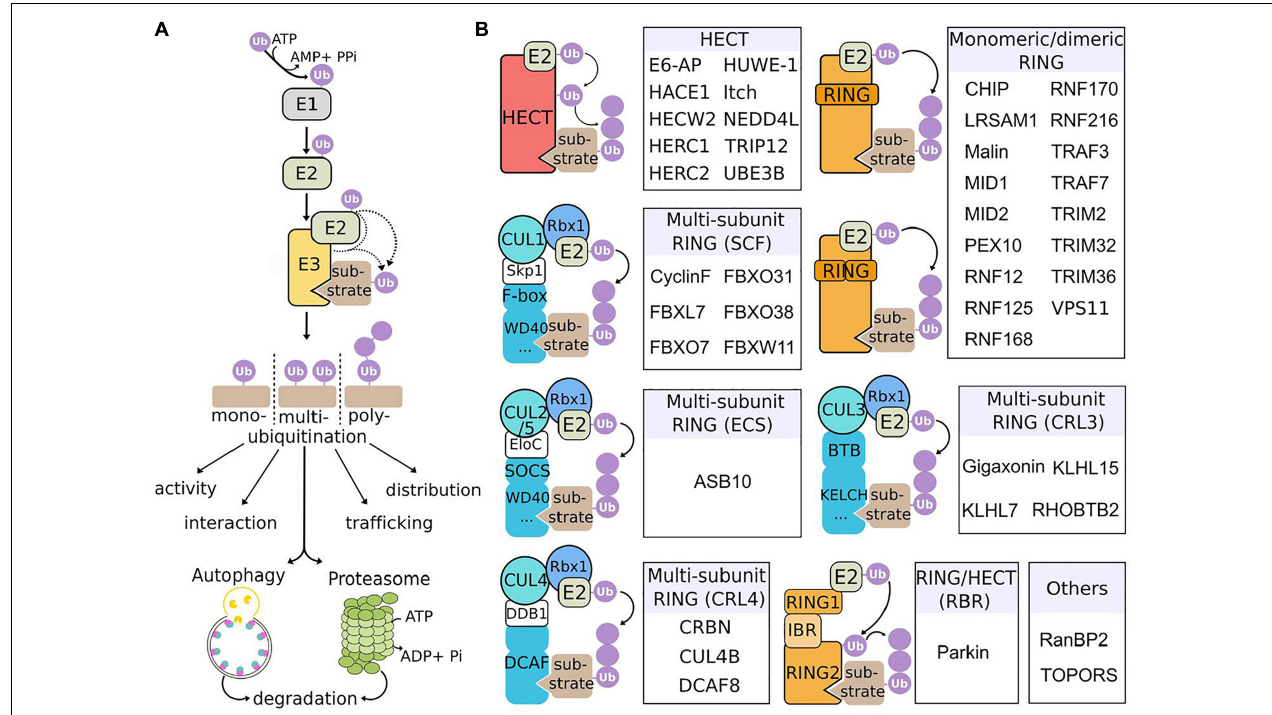
FIGURE 1 | Mechanism of action and classification of E3 ubiquitin ligases causing neurological diseases in human. (A) Ubiquitination cascade. E1 enzymes activate ubiquitin (Ub) in an ATP-dependent manner, forming a thioester bound with Ub. Activated-Ub is then transferred to Ub-conjugating enzymes (E2). Finally, E3 ubiquitin ligases assist or directly catalyze the transfer of Ub to substrates. Substrates can be mono-, multi- or poly-ubiquitinated, with different types of Ub chains, to modulate various processes, including protein activation, interaction, trafficking, subcellular localization, and degradation through the 26S proteasome or the autophagy pathway. (B) E3 ligases underlying neurological diseases and their classification. The three classes of E3 (HECT, RING, and RING-HECT hybrid) are represented. E3 ligases identified as the genetic cause of neurodevelopmental and neurodegenerative diseases in human are classified within each category (sub-classes with no disease representative are not shown). The HECT and RING E3 ligases differ in the way they transfer Ub to the substrate. The HECT E3s receive Ub from E2 enzymes, form a thioester intermediate with Ub, and catalyze the transfer to the substrate. RING E3s associate with E2 enzymes and substrates and mediate the transfer of Ub from E2 to the substrate. RING E3s can function as monomers, dimers or multi-subunit RING E3s. The latter class is subdivided in different groups, among which the Cullin-RING Ligases (CRLs) are the largest E3 ligase family. SCF, ECS, CRL3 and CRL4 ligases are composed of a modular E3 core containing specific Cullins (respectively CUL1, CUL2/5, CUL3, CUL4) and RBX1 (RING-box1 proteins), and a substrate specificity module composed of an adaptor (Skp1, EloC, and DDB1) and a substrate receptor. The RING-HECT hybrid ligases (RBR for RING-between-RING) interact with E2 as the RING E3 but transfer Ub with HECT-like mechanism. Finally, particular E3 are represented (“Others”): RanBP2 does not transfer Ub but Sumo (small ubiquitin-related modifier) and is neither an HECT, nor a RING E3 ligase; TOPORS has a RING domain and is a dual E3 Ub and Sumo